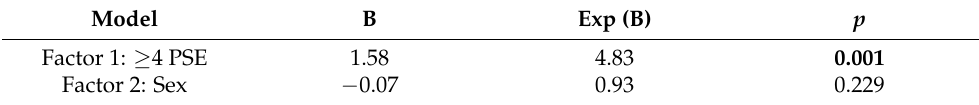
Table 3. Binary logistic regression analysis: risk prediction model of psychological